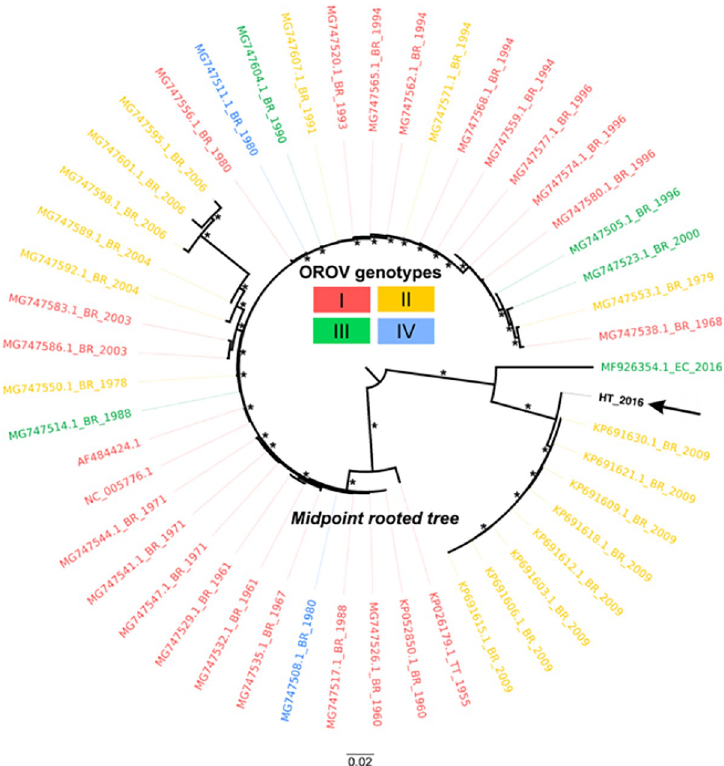
Fig 9. Maximum likelihood (ML) midpoint rooted tree based on 49 representative Large segment sequences (6830 sites) of OROV strains. Tips are colored according to genotype. OROV human isolate from this study (GenBank no. MN264267) is represented by the arrow and bolded name. Tip labels represents GenBank accession code, country of origin (BR, Brazil; PE, Peru; EC, Ecuador; HT, Haiti; TT, Trinidad and Tobago), and year of isolation. Asterisks assumes SH-aLTR/aBayes/ultrafast bootstrap support values. Only values equal or greater than 75% are shown. Branch lengths are drawn in scale of nucleotide substitutions per site according to the bar in the figure.